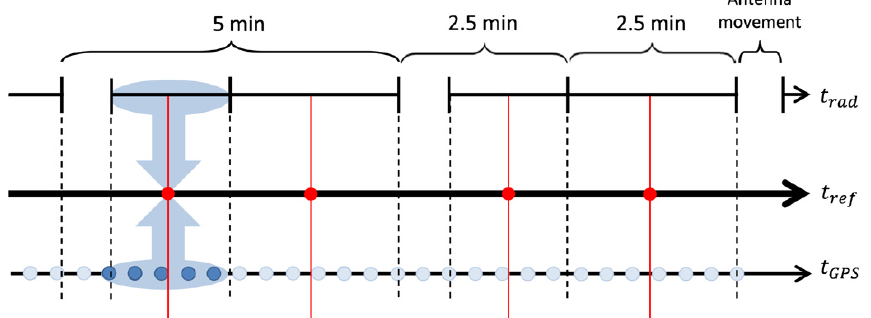
Fig. 3. The two GPS and radar data sets have different time axes ( t rad and t GPS ) . The reference time axis ( t ref ) used in the further analysis corresponds to the central point of the radar interval time (about 2.5min without considering the antenna movement time). The GPS values used in the analysis are taken from the average of the samples (about 10 every 2.5min) inside the radar time measurement window.